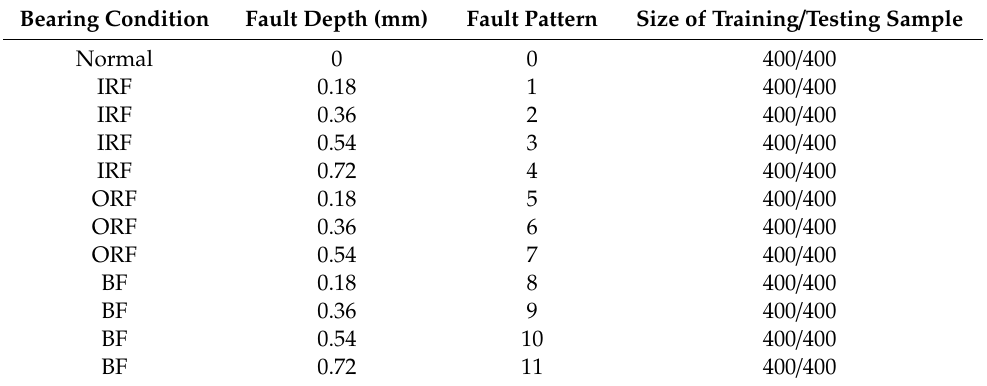
Table 5. Description of the sample distribution. IRF: inner race fault, ORF: outer race fault and BF: ball fault. Bearing